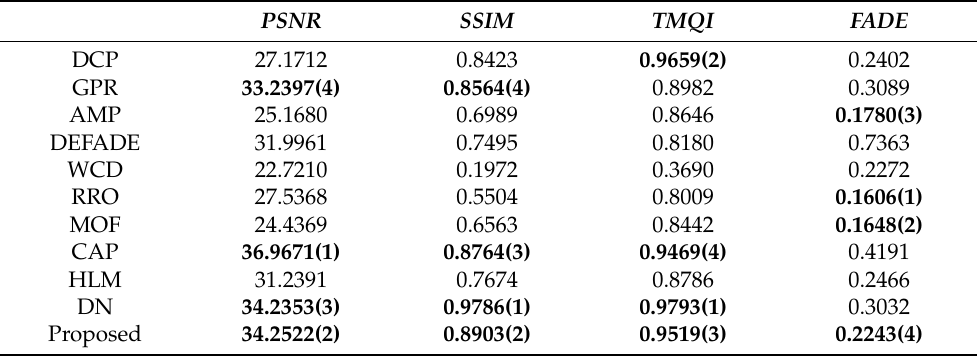
Table 3. Evaluation of four objective indexes in image dehazing experiments of synthetic hazy scenes. The top four results are marked in bold, and the corresponding rank is shown in the parenthesis (1: the best result, 2–4: the 2nd, 3rd, and 4th best results). The higher values of the PSNR , SSIM and TMQI indexes are better, the lower value of the FADE index is better.